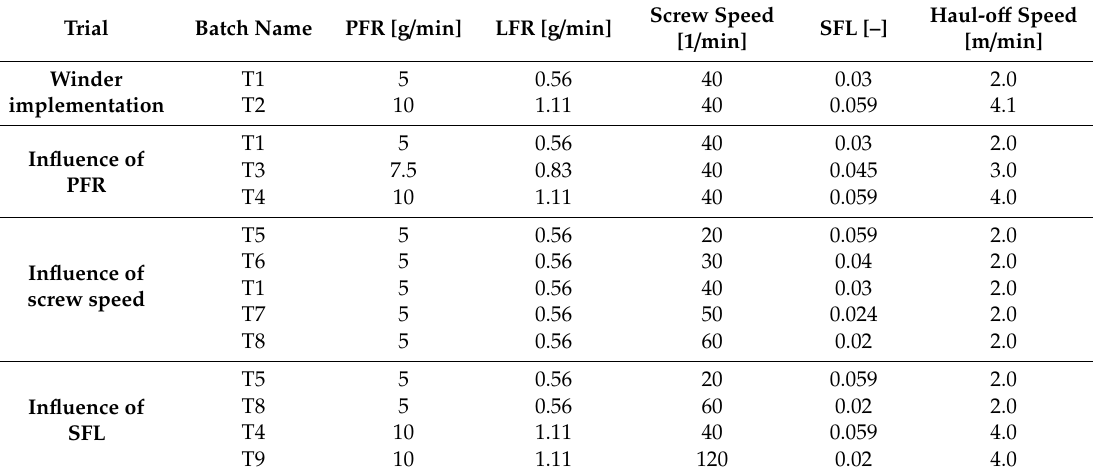
Table 1. Overview of experimental plan (SFL = specific feed